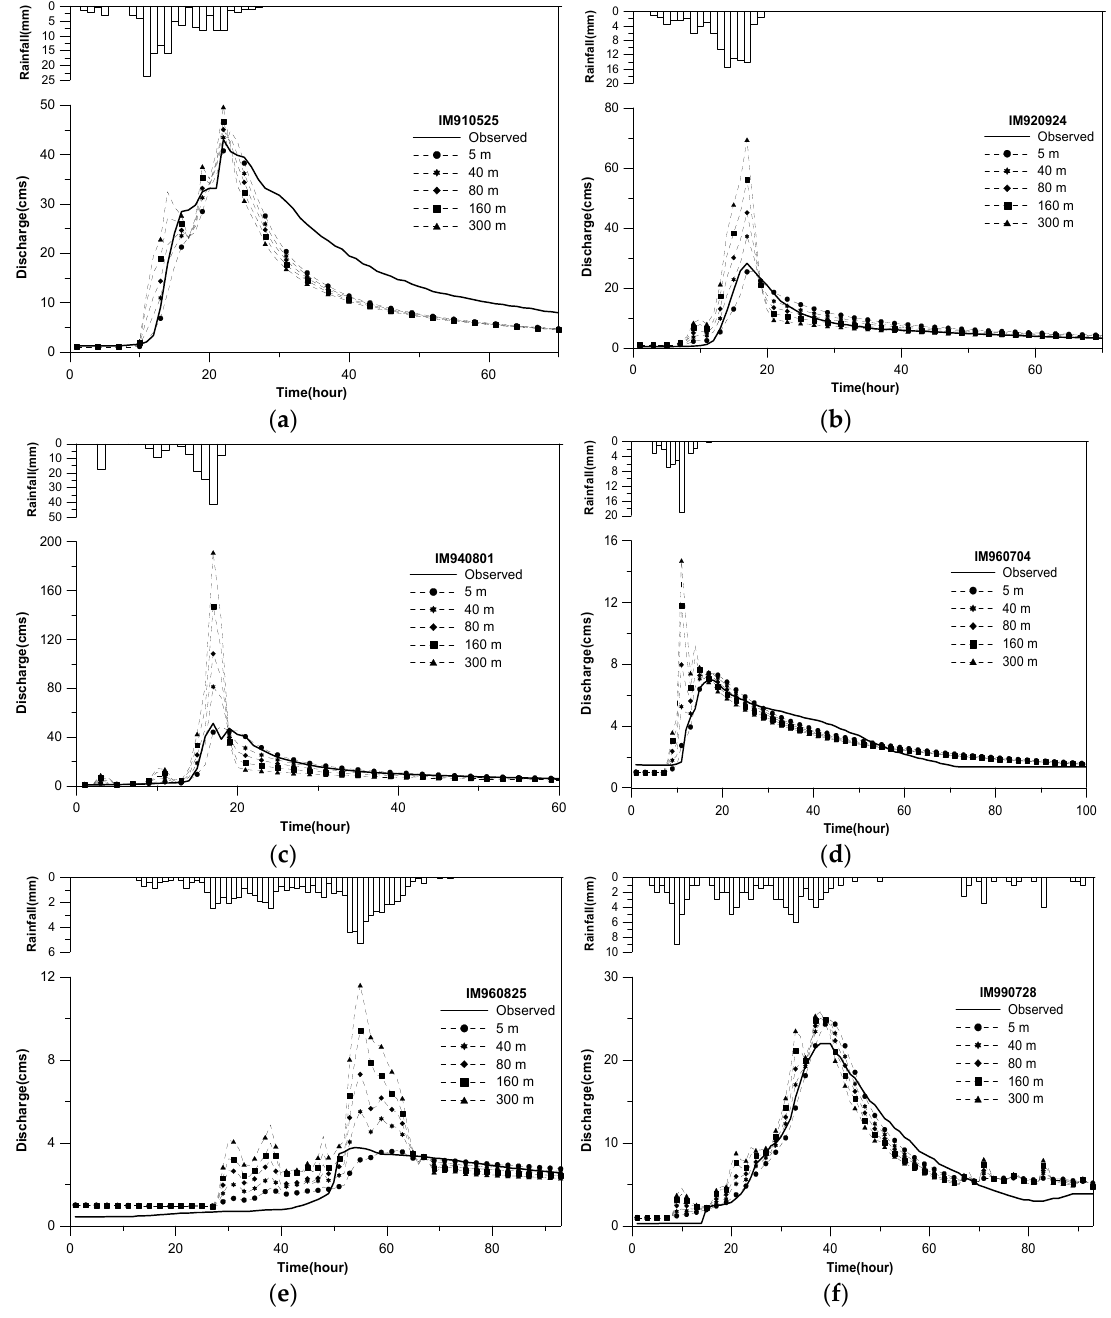
Figure 9. Rainfall–runoff events by applying a constant parameter set depending on different DEM resolution values in the Ieemokjung watershed. ( a ) 25 May 1991. ( b ) 24 September 1992. ( c ) 1 August 1994. ( d ) 4 July 1996. ( e ) 25 August 1996. ( f ) 25 July 1999.